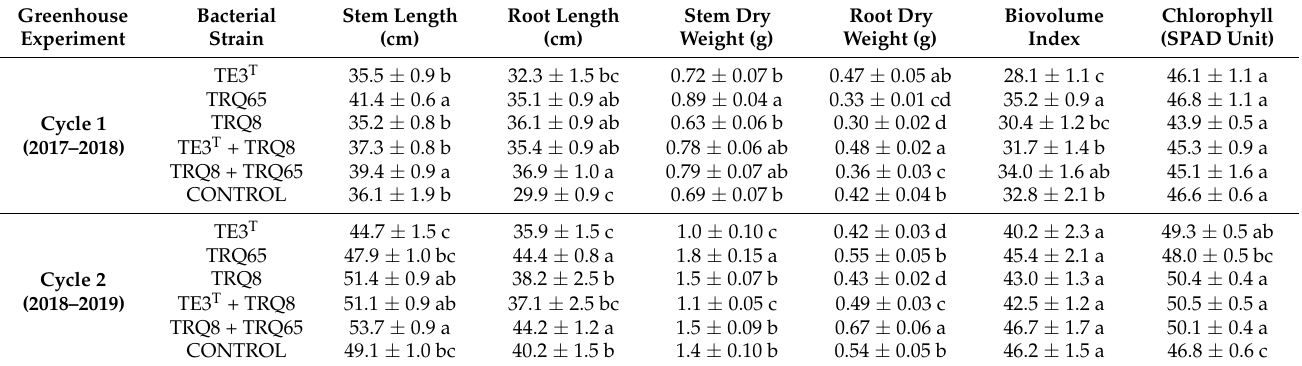
Table 2. Wheat growth promotion by Bacillus strains in microbeads (individual or consortium) and control (empty microbeads) on biometric plant parameters, in two cycles of greenhouse assay. Greenhouse Bacterial Experiment